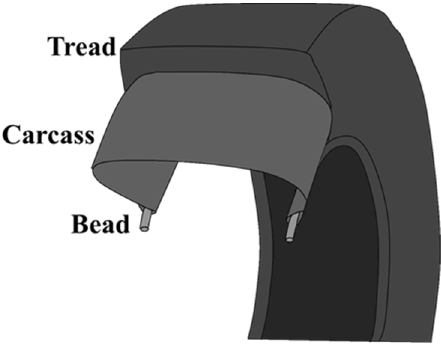
Figure 1. The major components of a tire include bead, carcass, and